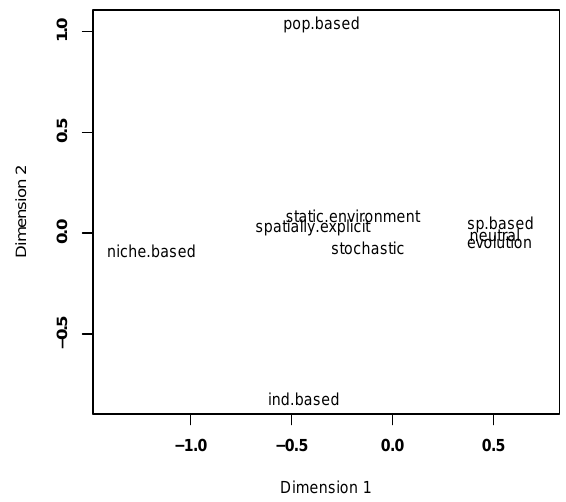
Figure 3. Multidimensional scaling of the model properties in the refined list of papers ( Stress − 1 = 0.126). The closer two properties are, the more often these properties are implemented simultaneously in models. The underlying data are shown in Table 1. ind.based: individual-based; pop.based: population-based; sp.based: species-based; other properties as in Figure 2. For this analysis, we used the same data as for producing Figure 2